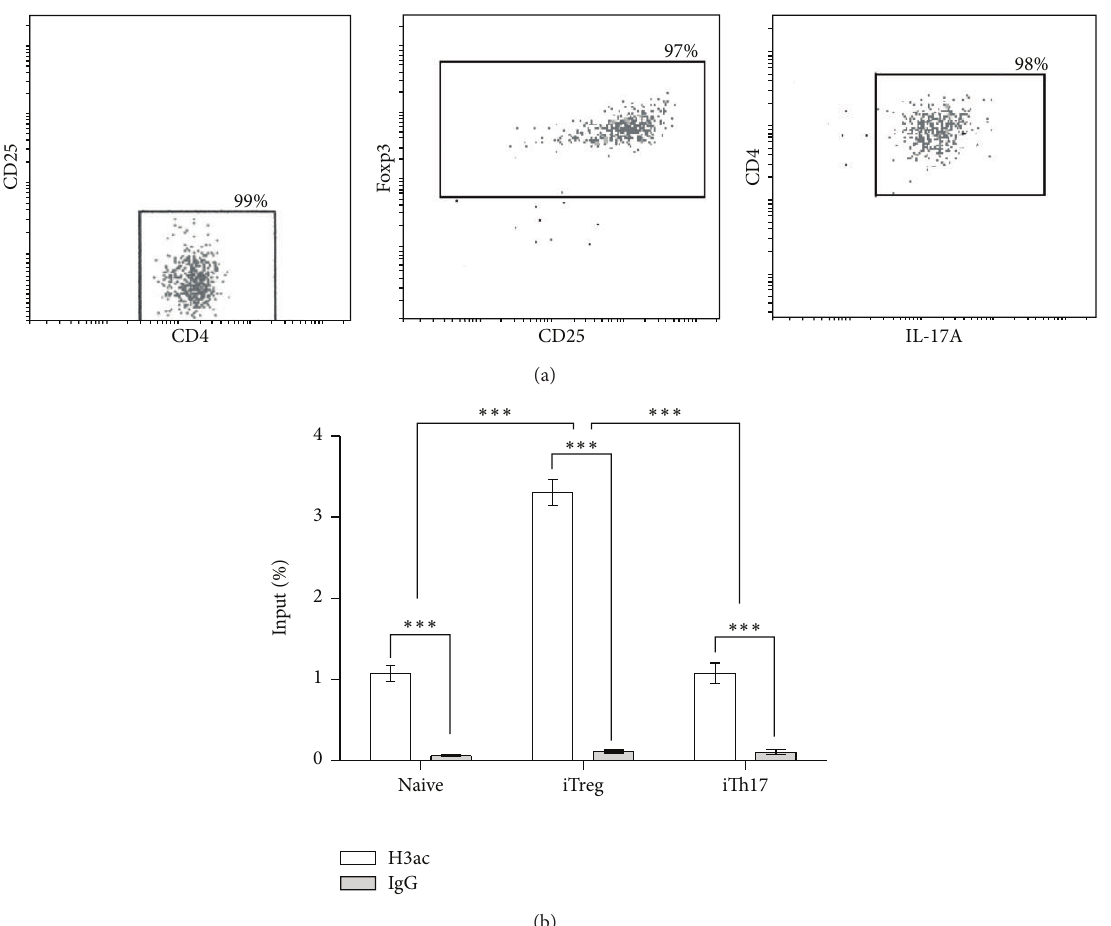
Figure 1: The foxp3 promoter is hyperacetylated on iTreg cells. (a) Flow cytometry of the sorted naive cells and in vitro differentiated Treg and Th17 cells. Numbers indicate the percentage of naive (CD4 + CD25 − ), Treg (CD4 + Foxp3 + ), and Th17 (CD4 + IL-17 + ) positive cells. (b) chromatin immunoprecipitation assays on foxp3 promoter. ChIP assays were performed on sorted splenic naive CD4 + T cells and in vitro induced Tregs and Th17 cells. DNA fragments bound to acetylated histones were immunoprecipitated using antibodies directed against acetylated histone H3 (H3ac) or a rabbit isotype-matched immunoglobulin G (IgG), as control. Precipitated DNA was quantified by real-time PCR with primers specific for the foxp3 gene promoter, and the PCR products were set in relation to input DNA. Standard deviation was obtained from three (naive and iTregs) and two (iTh17) independent